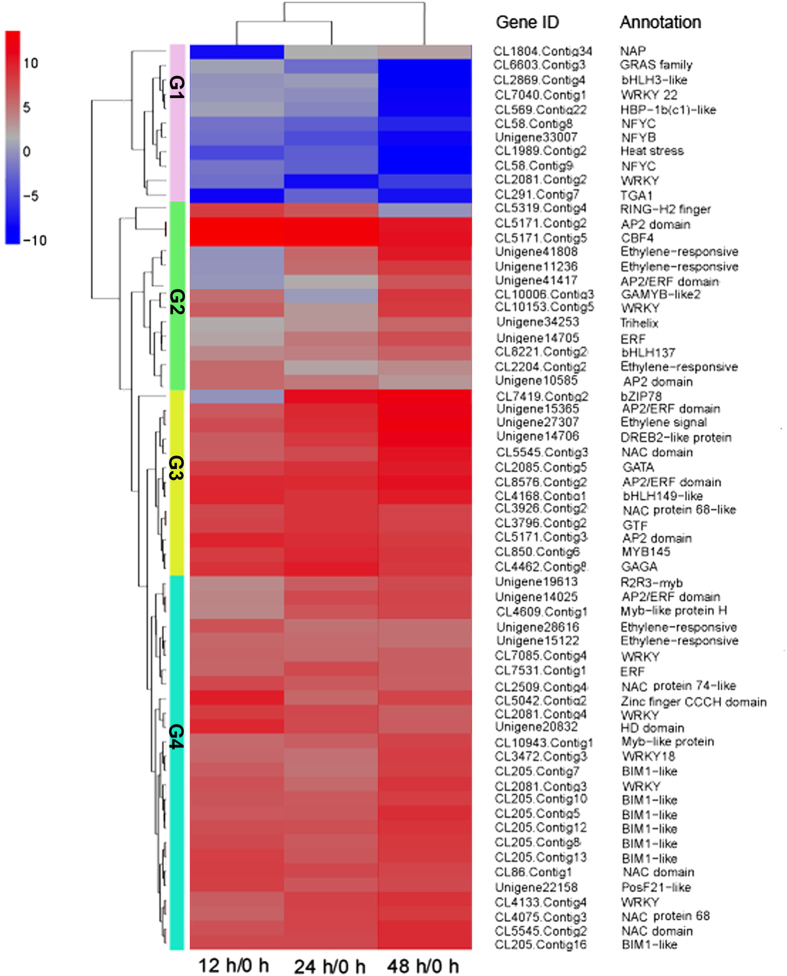
Hierarchically clustered heat map of cold regulatory transcript factor (TF) genes.The differentially expressed TFs were clustered into four groups (G1, G2, G3, and G4).